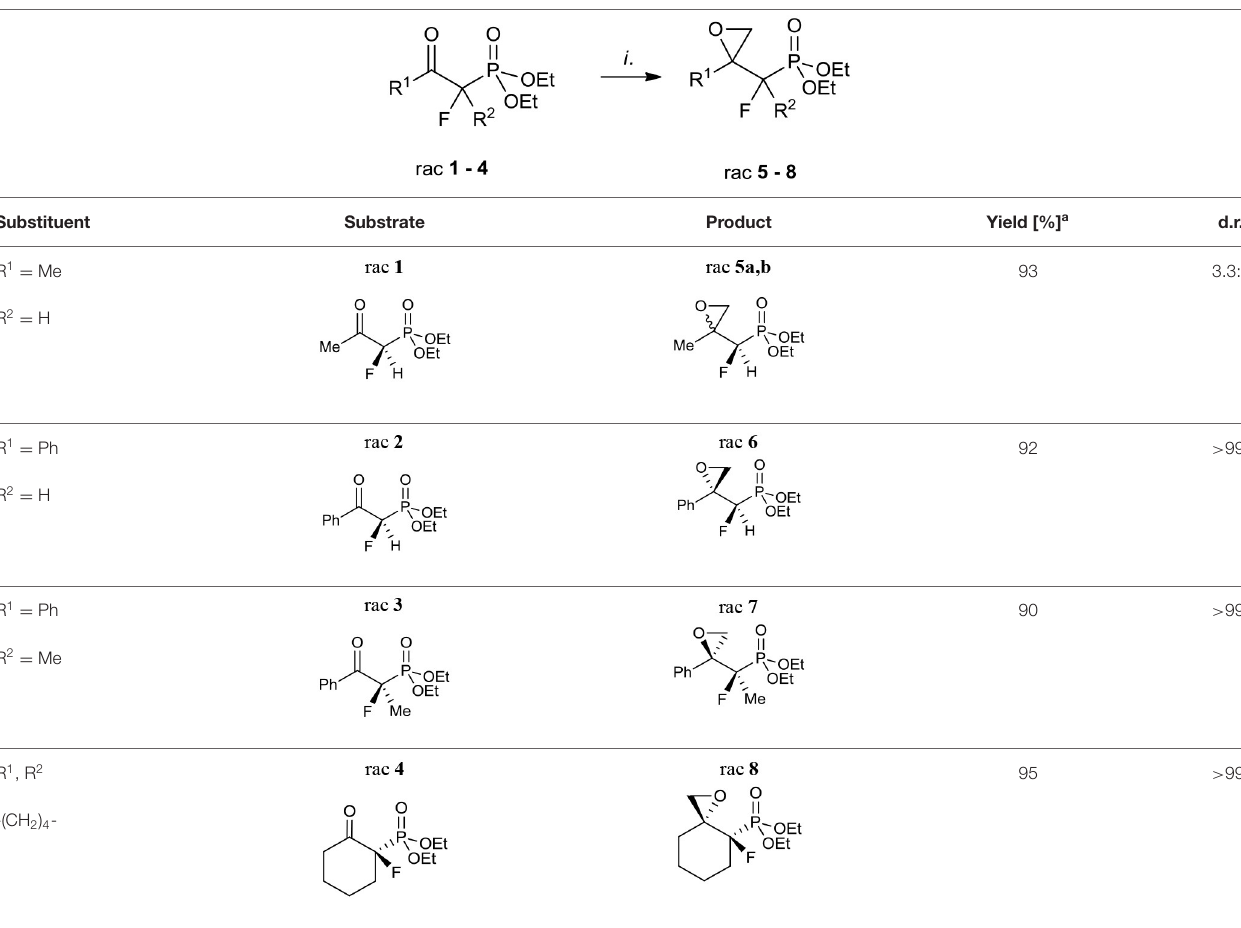
TABLE 1 | Synthesis of fluorinated epoxy alkylphosphonates 5–8